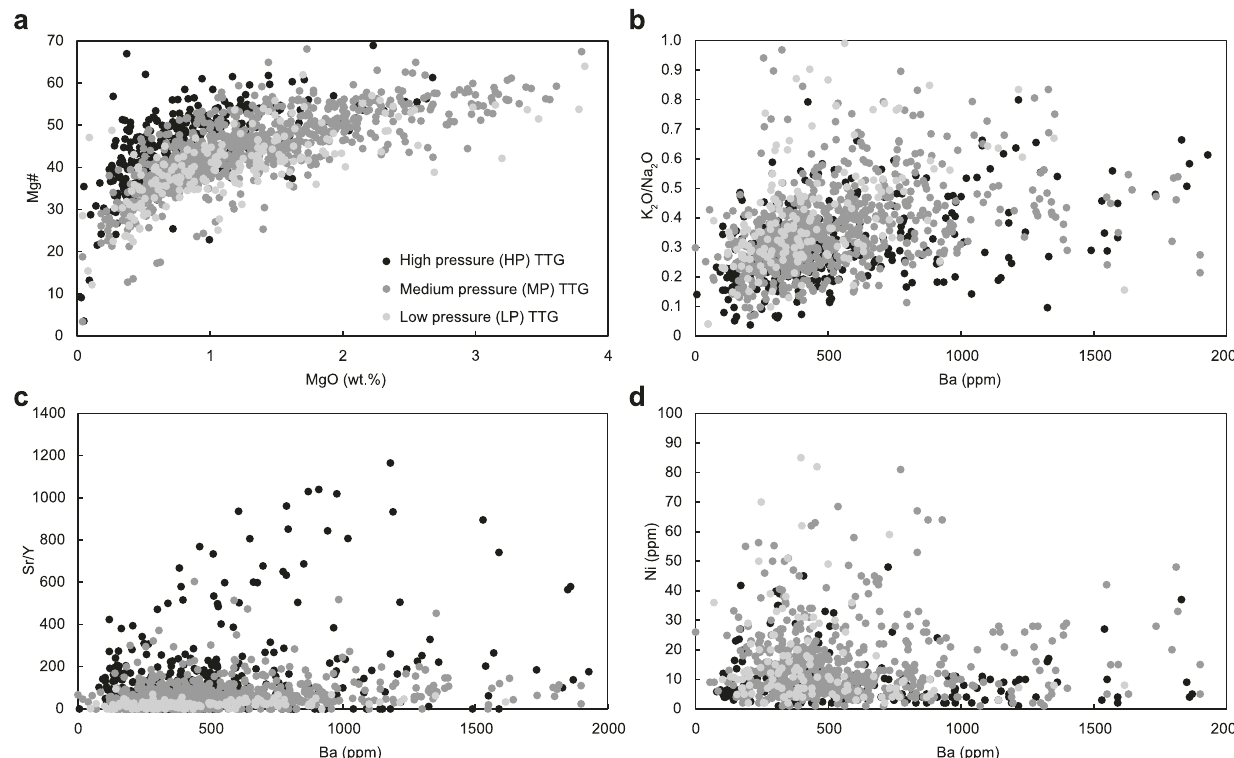
Fig. 1 | Compositions oftonalite – trondhjemite – granodiorite(TTG)suites.a Mg# versus MgO. b – d K 2 O/Na 2 O,Sr/Y, and Nicontents versus Bacontents. Data are from ref.